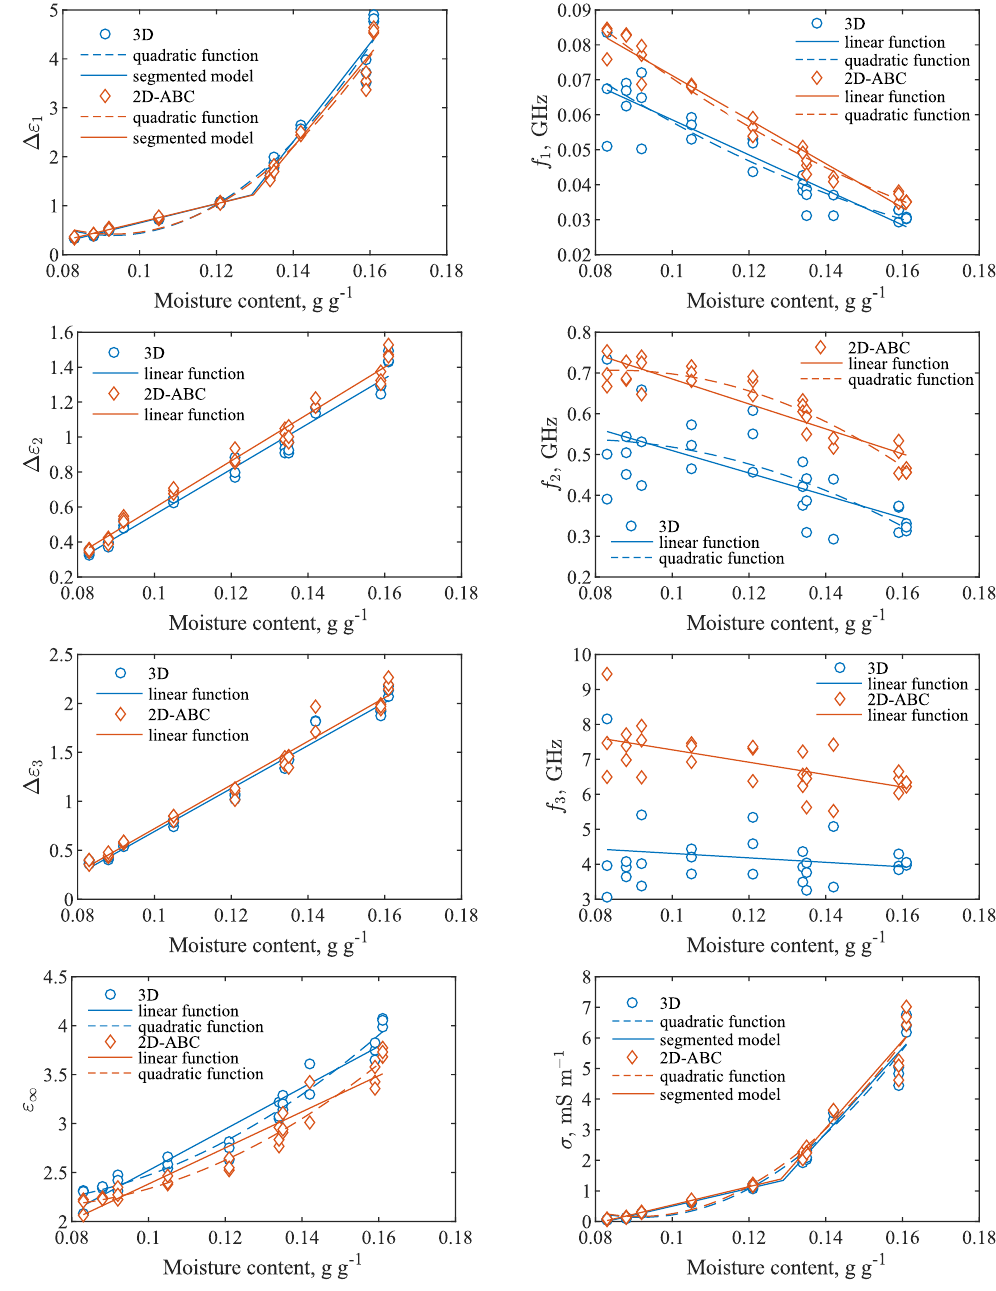
Figure 5. Parameters of the fitted models (Equations (4) and (6)) with respect to the rapeseed moisture content. In the case of the 2D-ABC model, parameters ε ∞ , ∆ ε 3 and f 3 were calculated with the use of Equation (7). The parameters’ dependencies on moisture content were modeled by linear, quadratic or segmented functions, as